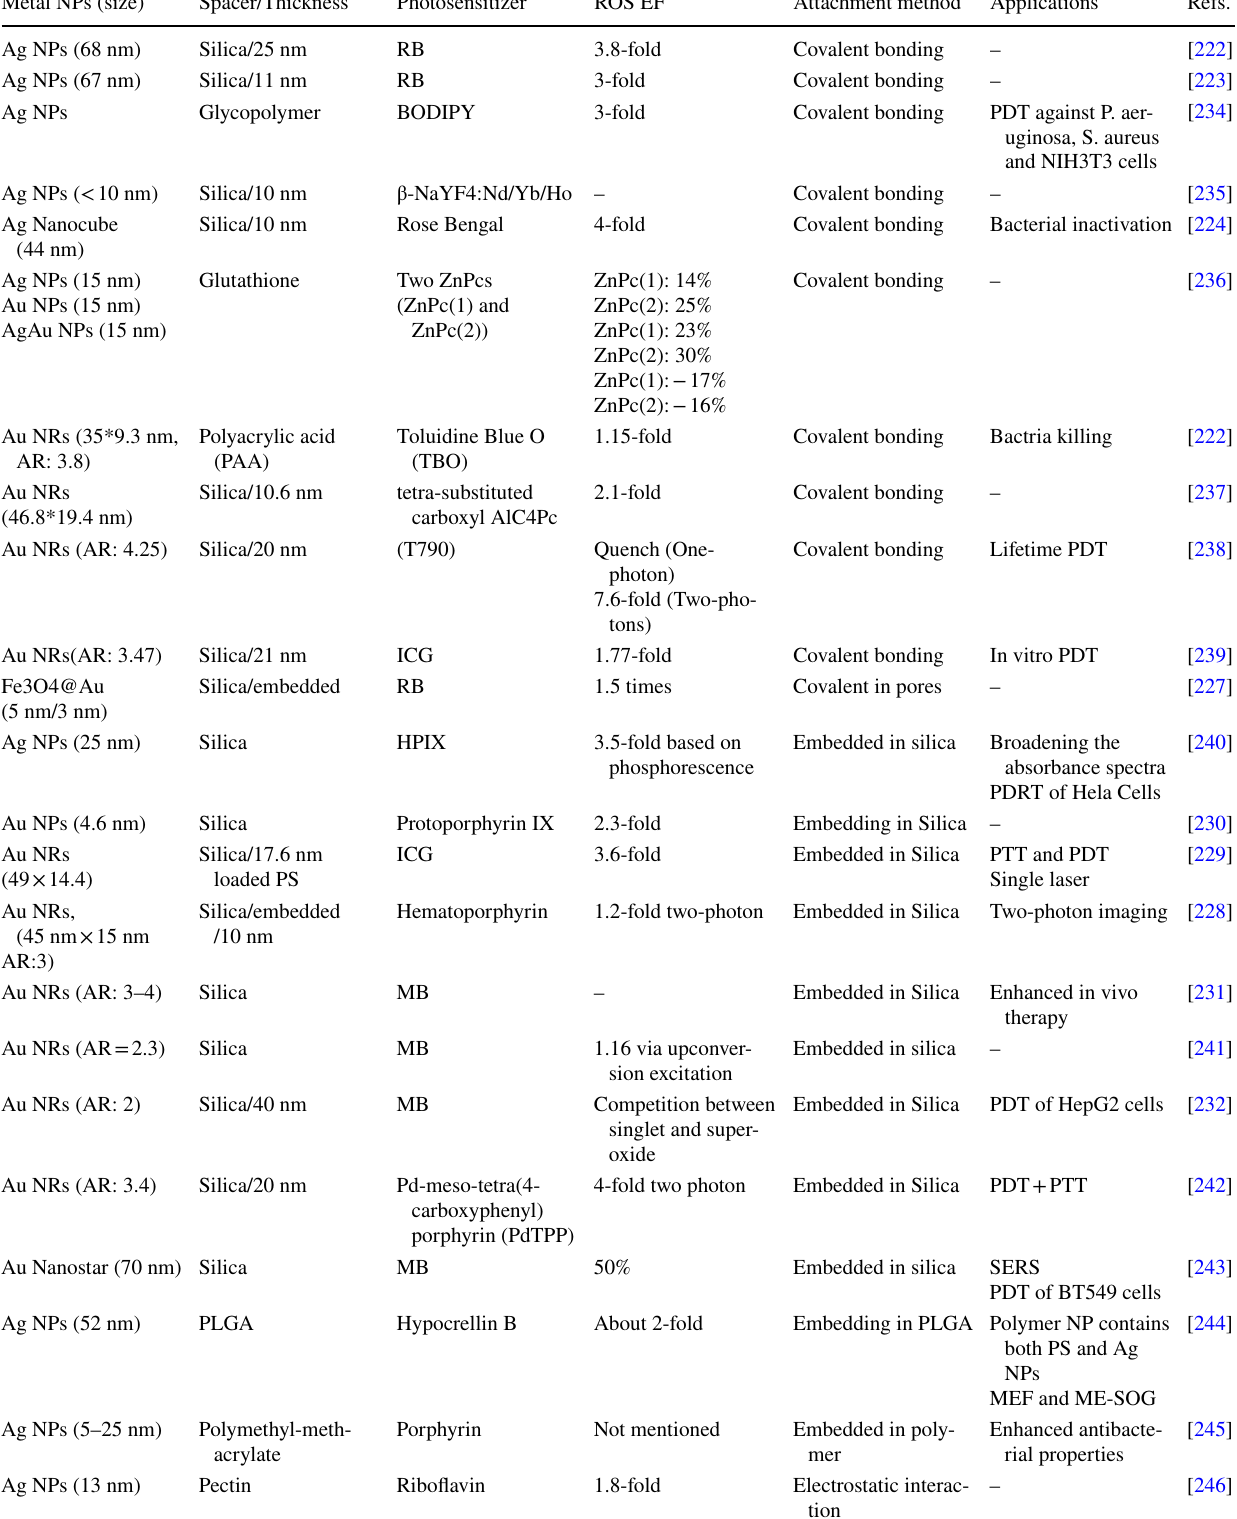
Table 3 Colloidal metal-photosensitizer systems with different types of dielectric spacer Metal NPs